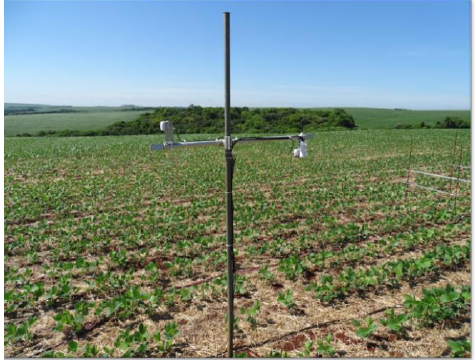
Figure 2. Incident (SRS NDVI Hemispheric) and reflected (SRS NDVI with Vision Limiter) radiation sensors installed in the experimental area. Carazinho/RS, 2017/18.